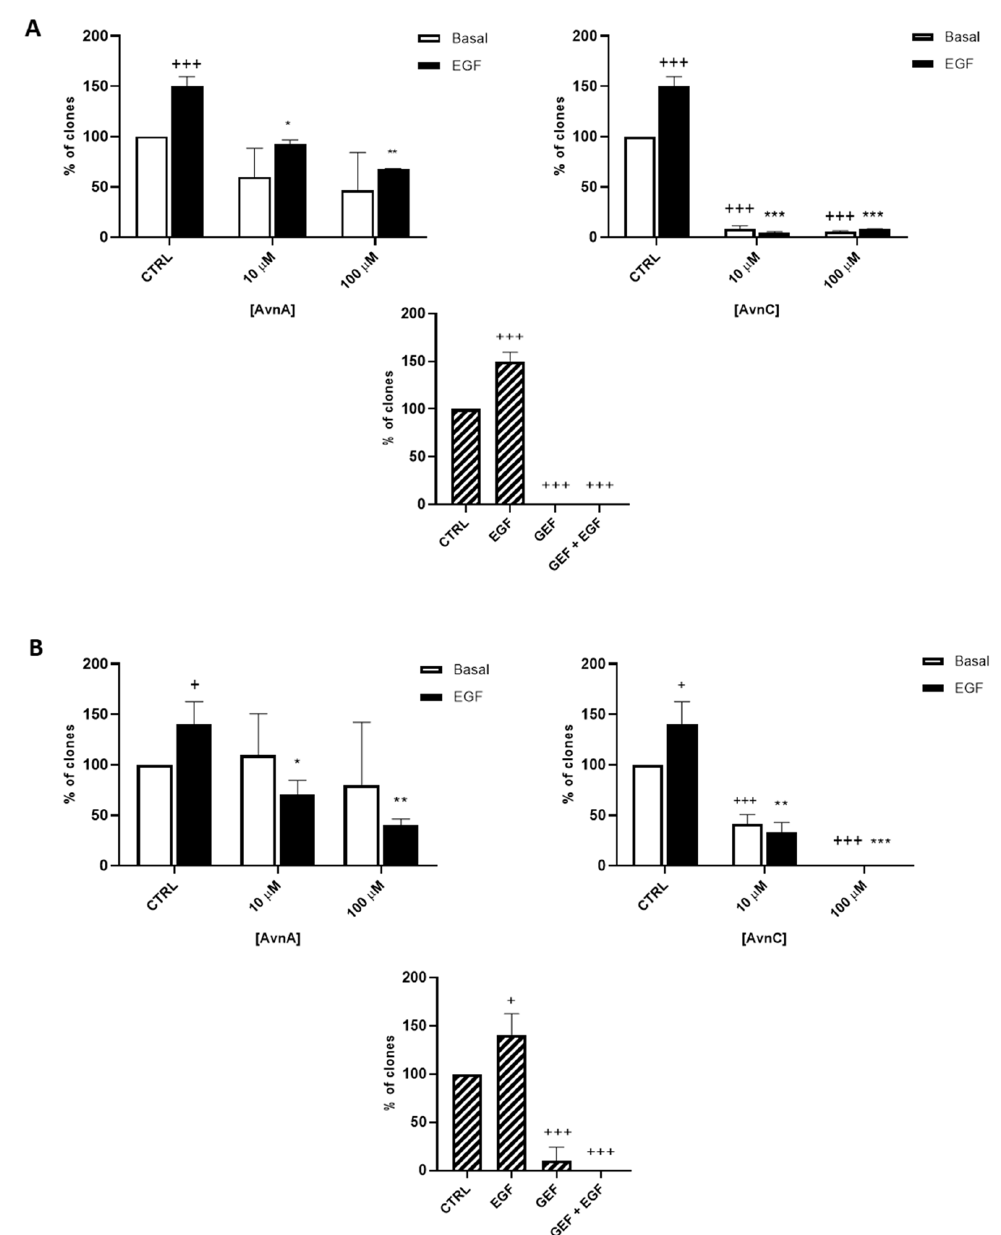
Figure 2. Natural Avns reduce clonogenicity of lung cancer cells promoted by EGF. Percentage of colonies of A 549 ( A ) and H1299 ( B ) cells in response to EGF in presence or absence of Avns. Data are expressed as % over basal control and are representative of three independent experiments run in triplicate. Statistical analysis: +++ p < 0.001 and + p < 0.05 vs. CTRL; *** p < 0.001; ** p < 0.01 and * p < 0.05 vs. EGF.